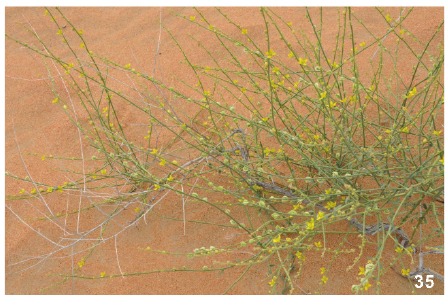
Figure 35. Capparaceae: Dipterygium glaucum